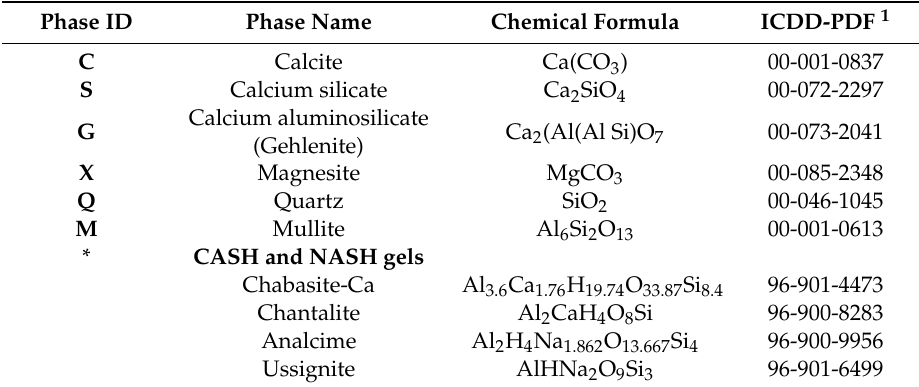
Figure 2. XRD patterns of FA and GA. Q = Quartz, M = Mullite, * = NASH type gels. Table 2. Crystalline phases identified by XRD.